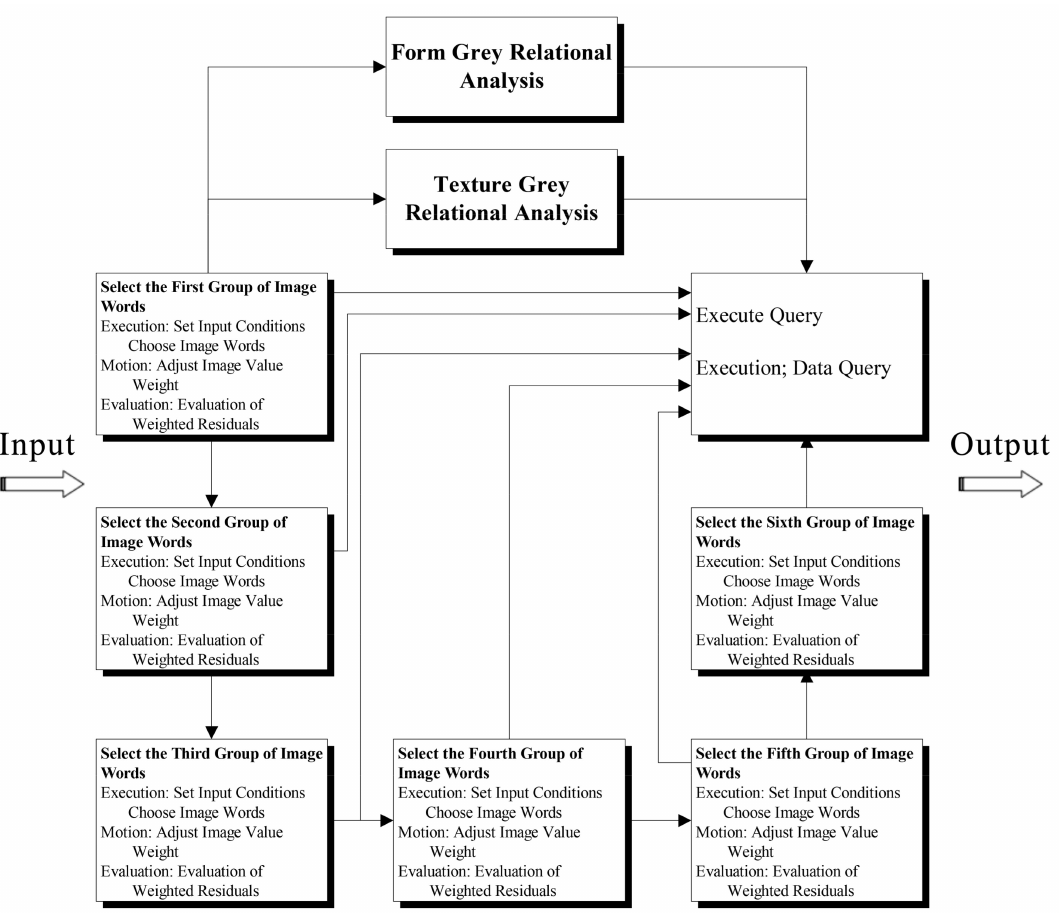
Figure 11. Simply consider input word, form and texture as the main set